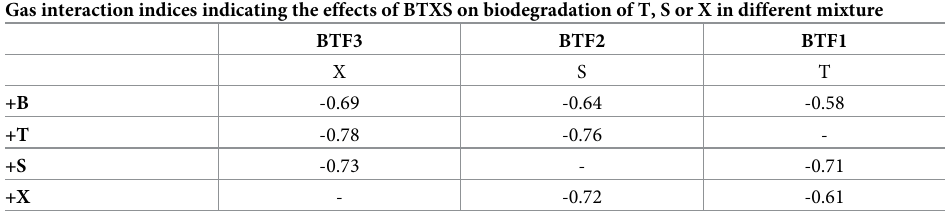
+X - B: benzene; T: toluene; X: xylene; S: styrene; BTF: Biotrickling